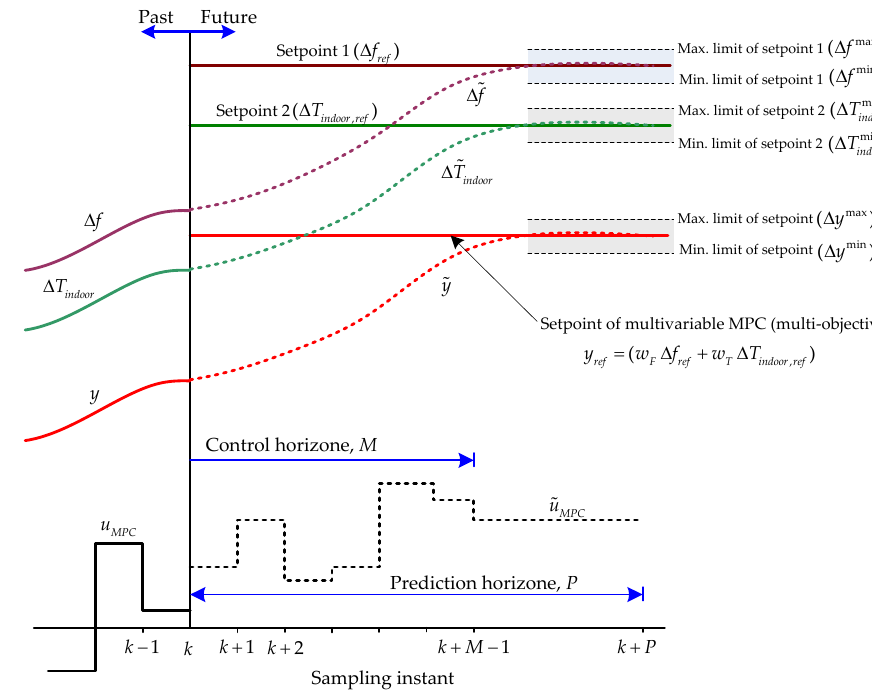
Figure 5. Multivariable MPC for IACs control.